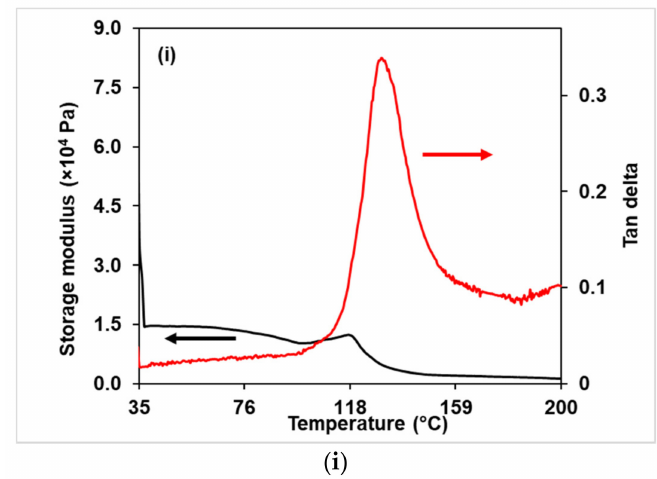
Figure 5. Tan δ and storage modulus of ( a ) NMPC/PVA-30 membrane, ( b ) NMPC/PVA-35 membrane, ( c ) NMPC/PVA-40 membrane, ( d ) NMPC/PVA-45 membrane, ( e ) NMPC/PVA-50 membrane, ( f ) NMPC/PVA-55 membrane, ( g ) NMPC/PVA- 60 membrane, ( h ) NMPC/PVA-65 membrane, and ( i ) NMPC/PVA-70